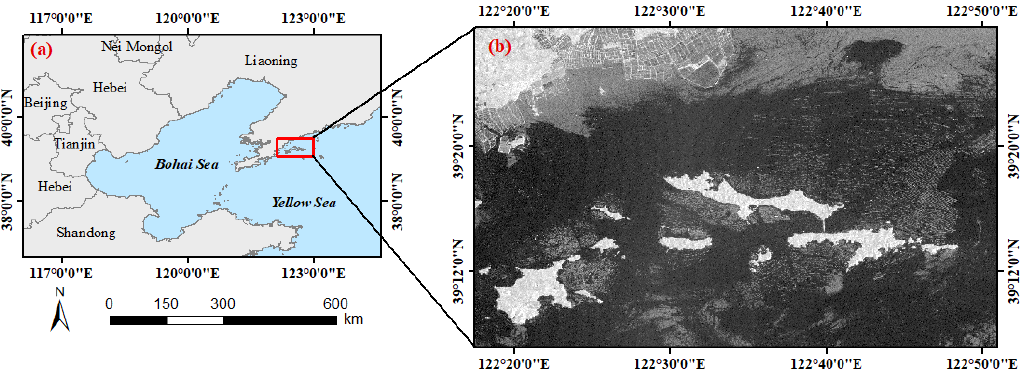
Figure 3. Study area: ( a ) location; ( b ) SAR data of the study area.